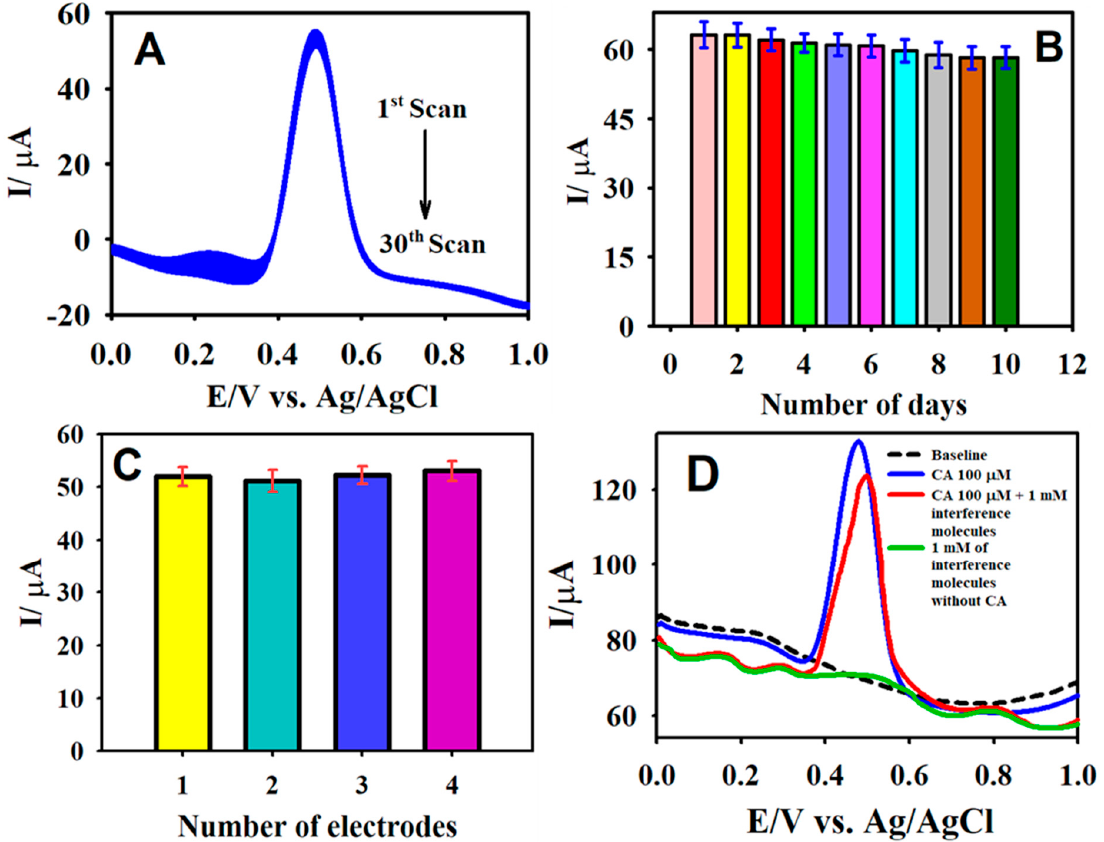
Figure 8. The DPV curves of the F-GO/GCE recorded in 50.0 μ M CA over 30 consecutive Figure 8. The DPVcurves ofthe F-GO/GCErecordedin 50.0 µ MCA over 30consecutive measurements ( A ); measurements ( A ); the DPV response of F-GO/GCE measured in 50.0 μ M CA for 10 days ( B ); the DPV the DPV response of F-GO/GCE measured in 50.0 µ M CA for 10 days ( B ); the DPV response recorded response recorded in the presence of 50.0 μ M CA with four different F-GO/GCEs ( C ); and the in the presence of 50.0 µ M CA with four different F-GO/GCEs ( C ); and the interference response of the interference response of the F-GO/GCE for the detection of 100.0 μ M CA in the presence of 1.0 mM p - F-GO/GCE for the detection of 100.0 µ M CA in the presence of 1.0 mM p -coumaric acid, hydroquinone, coumaric acid, hydroquinone, trans-ferulic acid, gallic acid, glucose, and ascorbic acid ( D ). trans-ferulic acid, gallic acid, glucose, and ascorbic acid ( D ). Electrolyte: a 0.1 M B-R buffer solution Electrolyte: a 0.1 M B-R buffer solution (pH 2.65). (pH